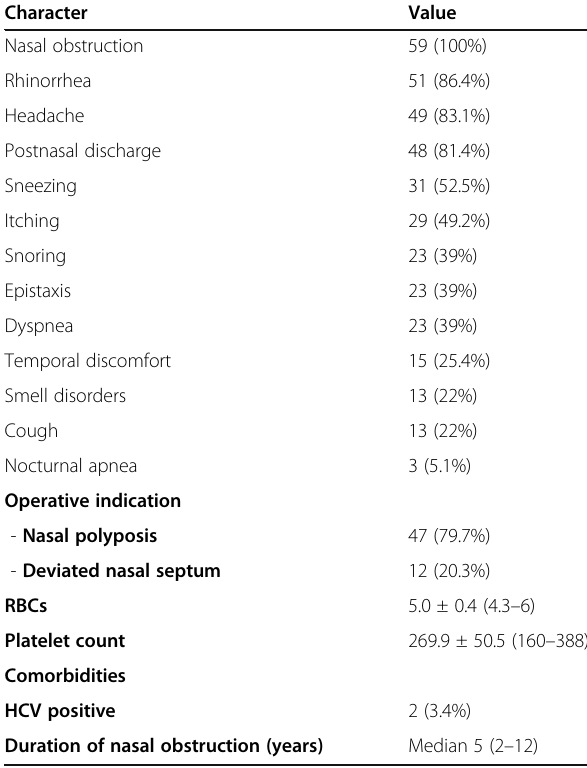
Table 2 Clinical data of the studied